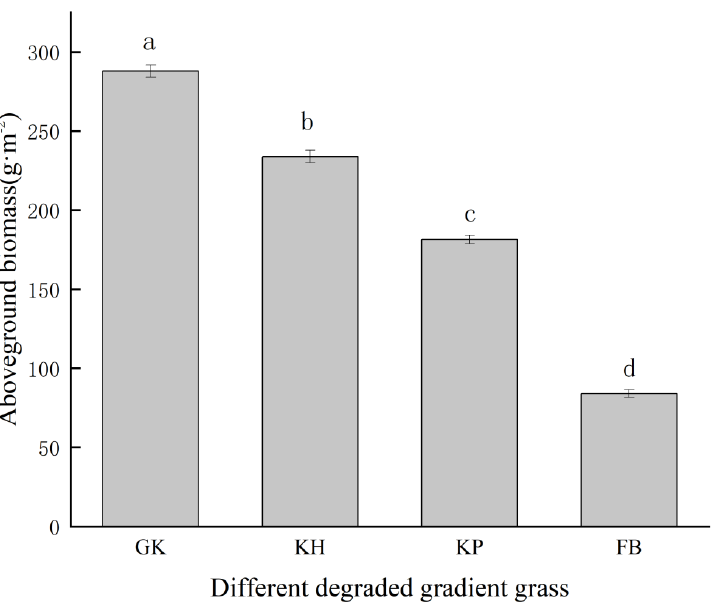
Figure 3. Aboveground biomasses of multi − stable alpine meadows. The error bar represents the standard error. Letters above bars mean a statistical significance was detected using ANOVA and Duncan’s post hoc test ( α = 0.05). GK, Gramineae grass – Kobresia humilis community; KH, K. humilis Duncan’s post hoc test (α = 0.05). GK, Gramineae grass − Kobresia humilis community; KH, K. humilis community; KP, K. pygmaea community; FB, Forbs-Black soil. community; KP, K. pygmaea community; FB, Forbs-Black soil.